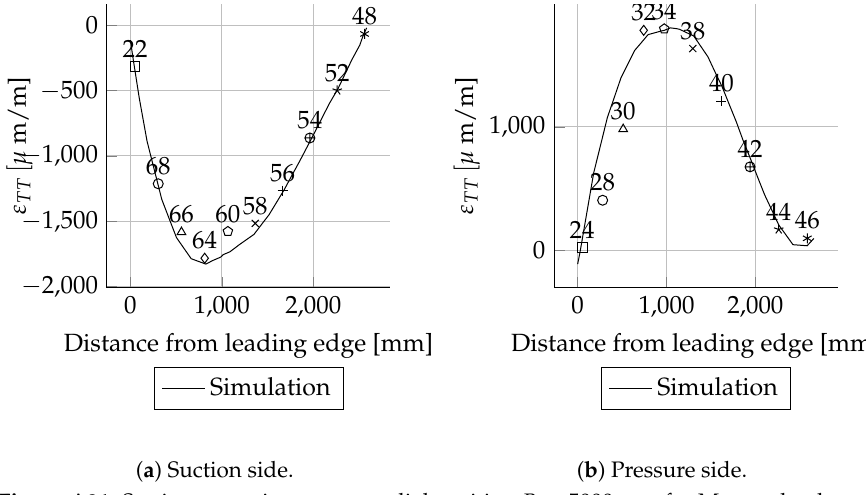
Figure A31. Strain comparison ε LL at radial position R = 5000 mm for Mymax load case.